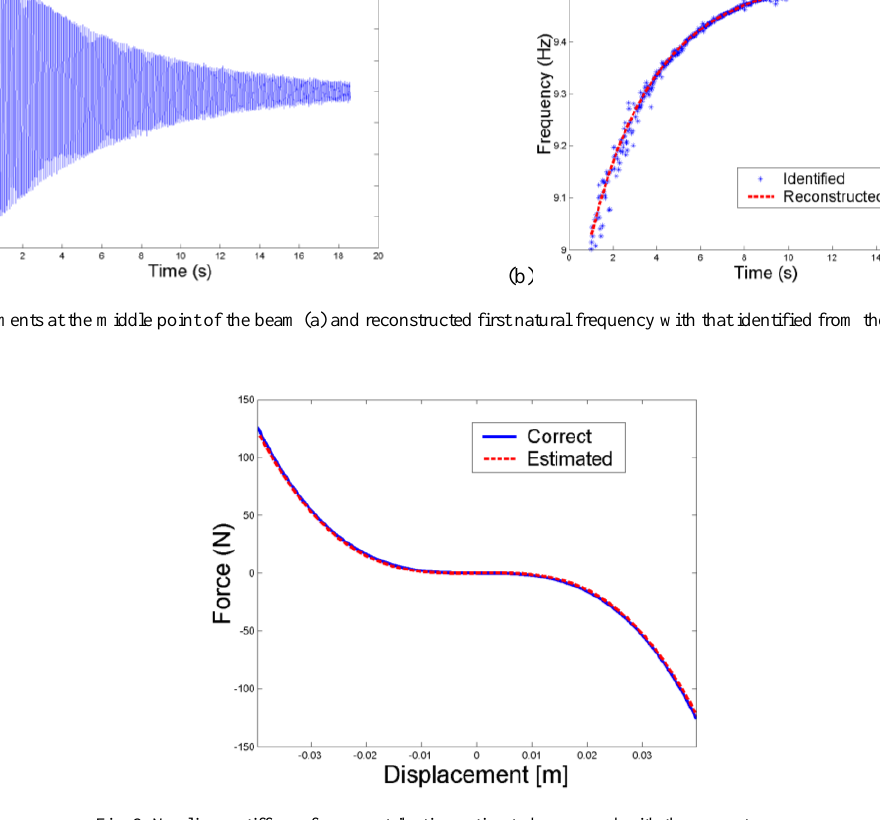
Fig. 2. Nonlinear stiffness force contribution estimated compared with the correct one.